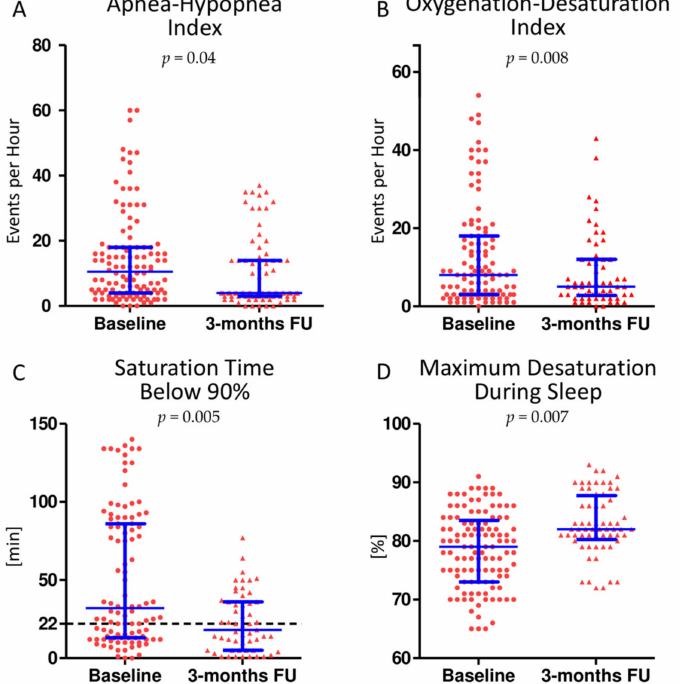
Figure 2. Sleep disordered breathing (SDB) parameters improve after elimination of mitral regurgita- tion. Apnea hypopnea index ( A ), the oxygenation desaturation index ( B ) and the oxygen saturation time below 90% ( C ) improved significantly three months after mitral valve surgery. In addition, the oxygen saturation during sleep did not decrease as much as before surgery ( D ). The prognostically relevant time of oxygen saturation of 22 min (black line, ( C )) was no longer exceeded in most patients after surgery. Scatter dot plots are lined at mean with interquartile range.